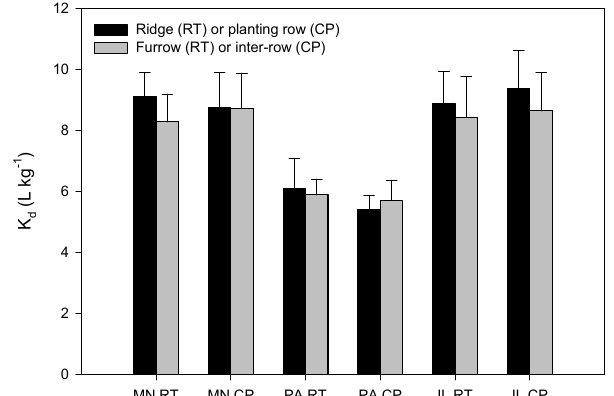
Figure 1. Alachlor sorption on MN, PA, and IL soils under ridge-till (RT) and chisel-plow (CP) tillage management systems. RT data are separated into ridge and furrow sampling positions, while CP data are separated into planting row and inter-row soils. K d values shown are the replicate means (MN, PA: n = 8; IL: n = 16); error bars represent standard deviation.